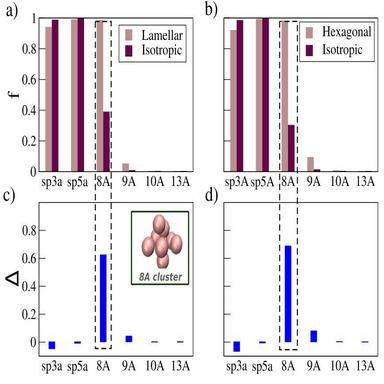
Characterization using the Topological Cluster Classification. (a-b) The fractions found for different clusters analyzed in the mesophase and the isotropic state. (c-d) The difference in the fraction of each cluster between the ordered and disordered phases.